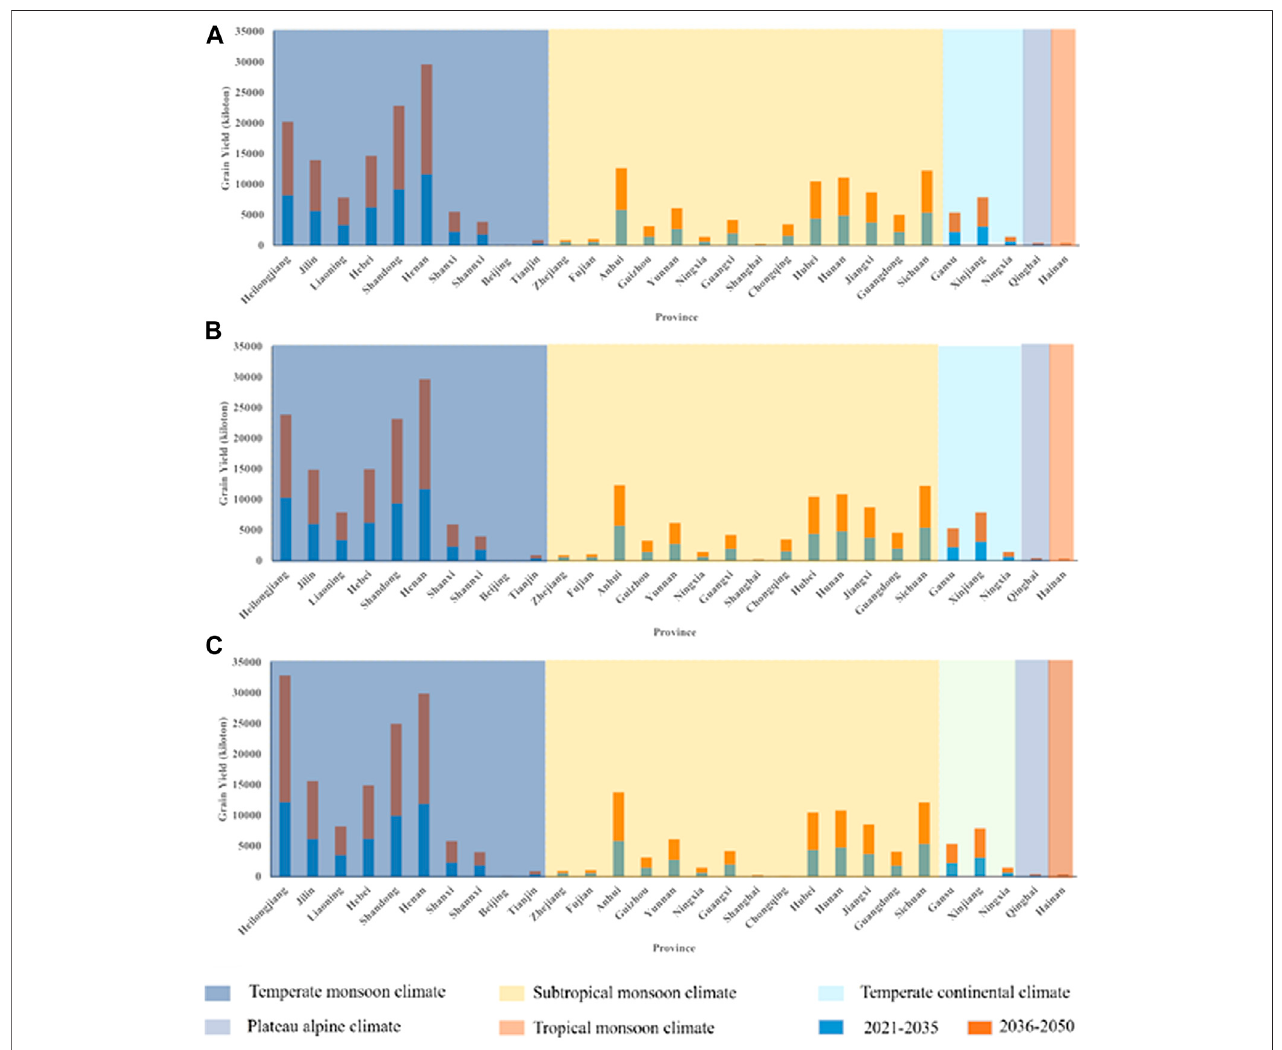
FIGURE 4 | China ’ s total grain yield in 2020 – 2050 under different emissions scenarios (A) SSP1 – 2.6, (B) SSP2 – 4.5, (C) SSP5 – 8.5.